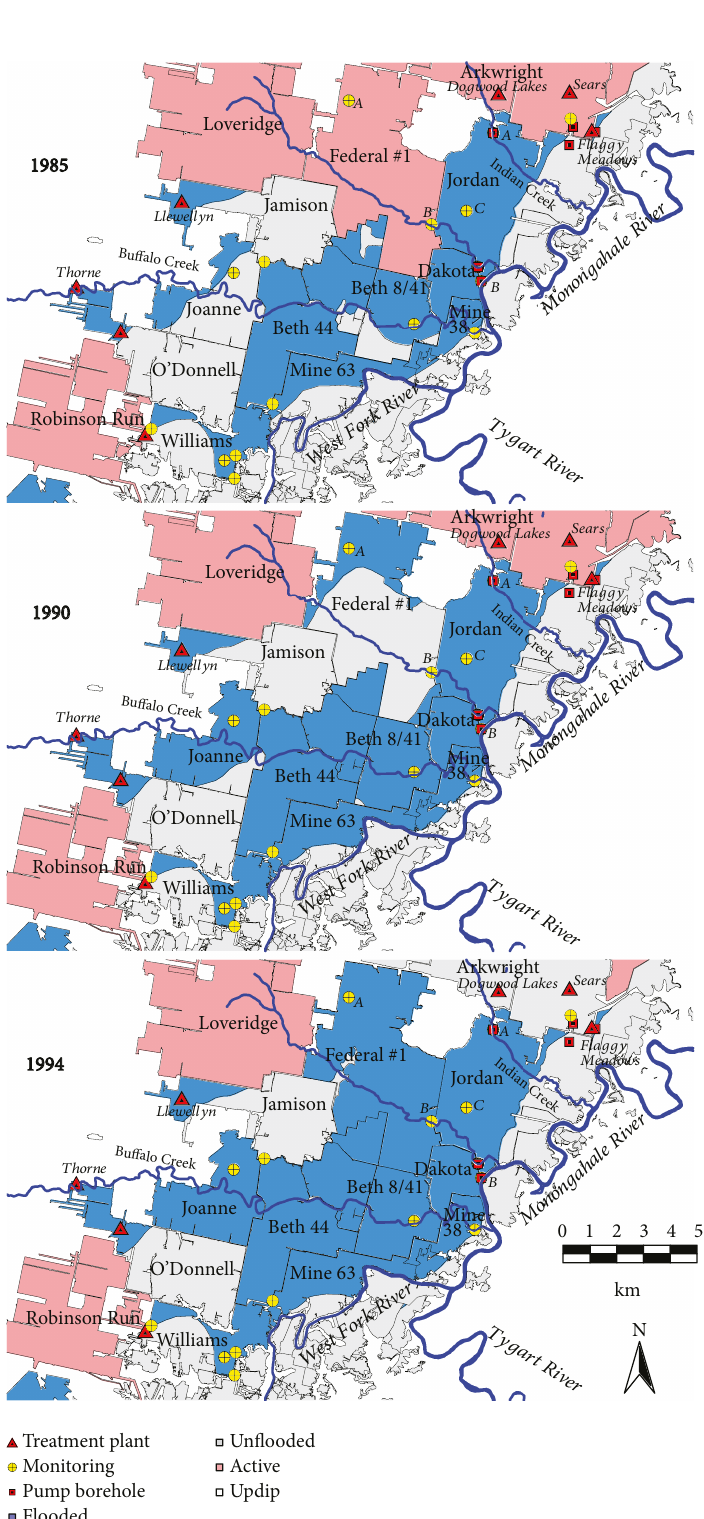
Figure 7: Flooding extent in closed mines, 1985 – 1994. Interior coal pillars are omitted for